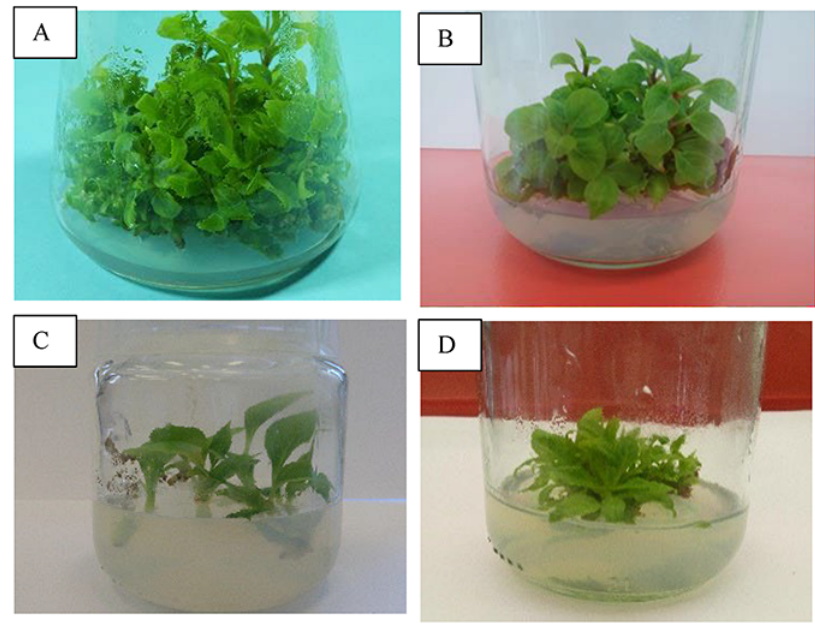
Figure 12 Agar microshoot cultures of ( A ) Schisandra chinensis , ( B ) S. chinensis ‘Sadova’, ( C ) S. henryi , and ( D ) S. rubriflora